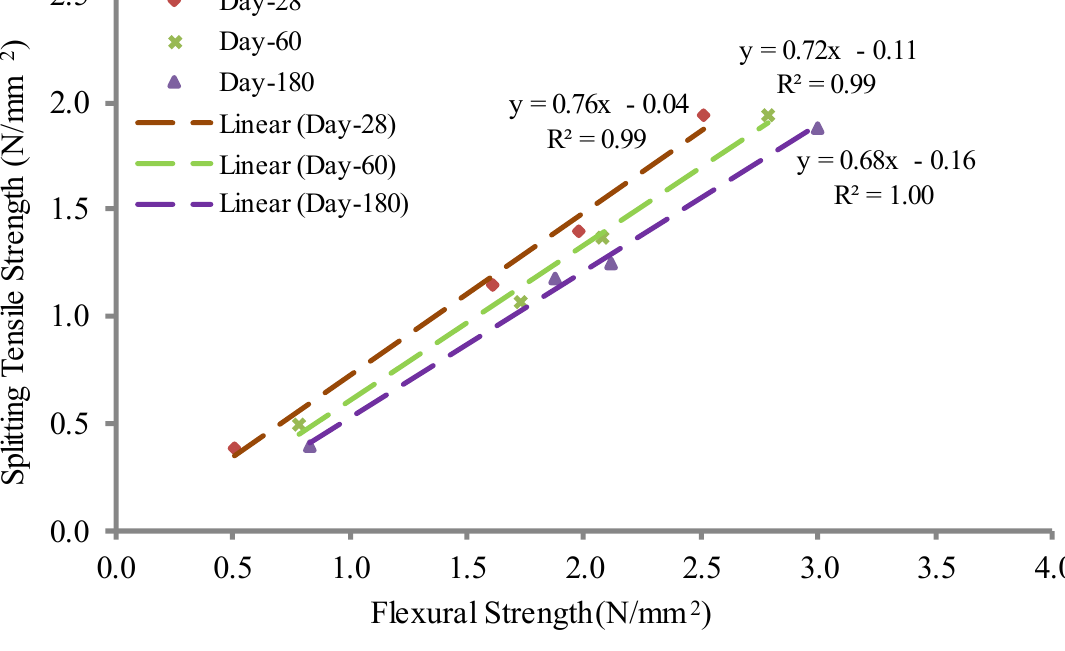
Figure 14. Correlation between foamcrete flexural and splitting tensile strengths.